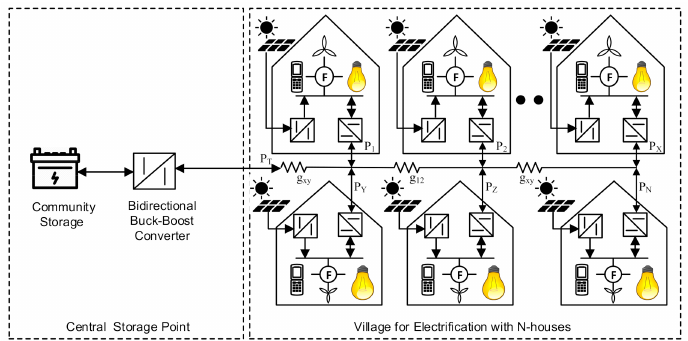
Figure 3. System diagram for distributed generation and central storage architecture